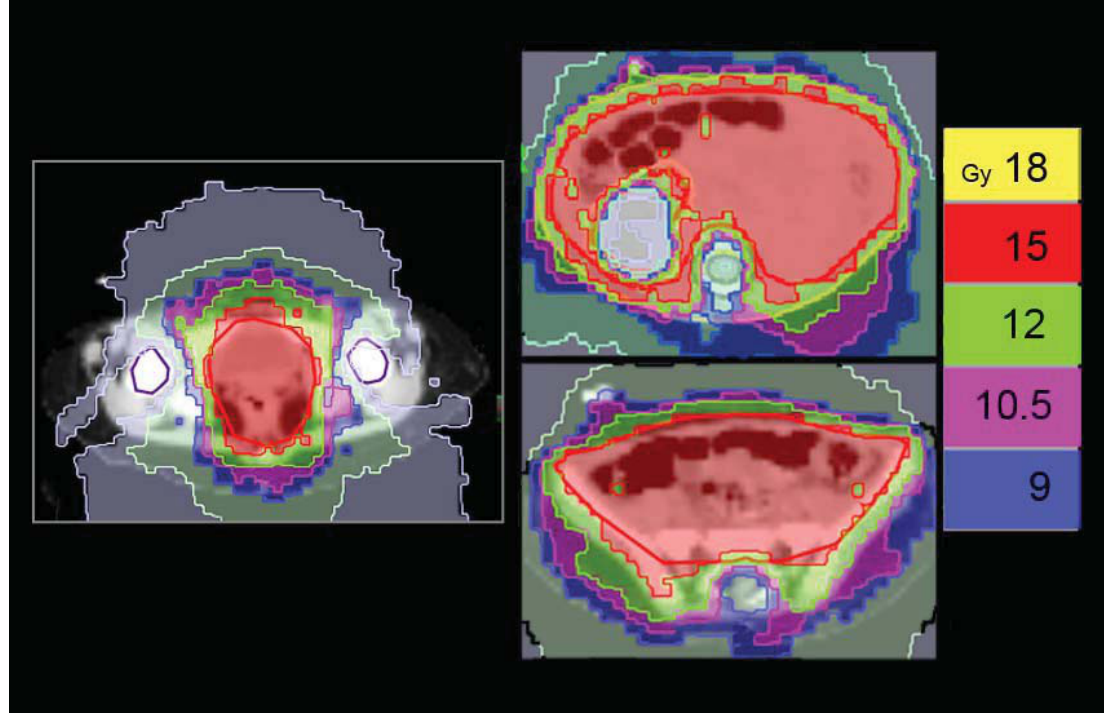
Figure 10. A 2-year-old female with left kidney Wilms’ tumor and preoperative rupture in the abdomen. HT allows a greater homogeneity in whole abdomen irradiation with concomitant sparing of the healthy kidney to less than 40% of the prescribed dose. The technique provided adequate coverage of the peritoneal cavity while limiting the dose to the residual kidney, spinal cord and bone